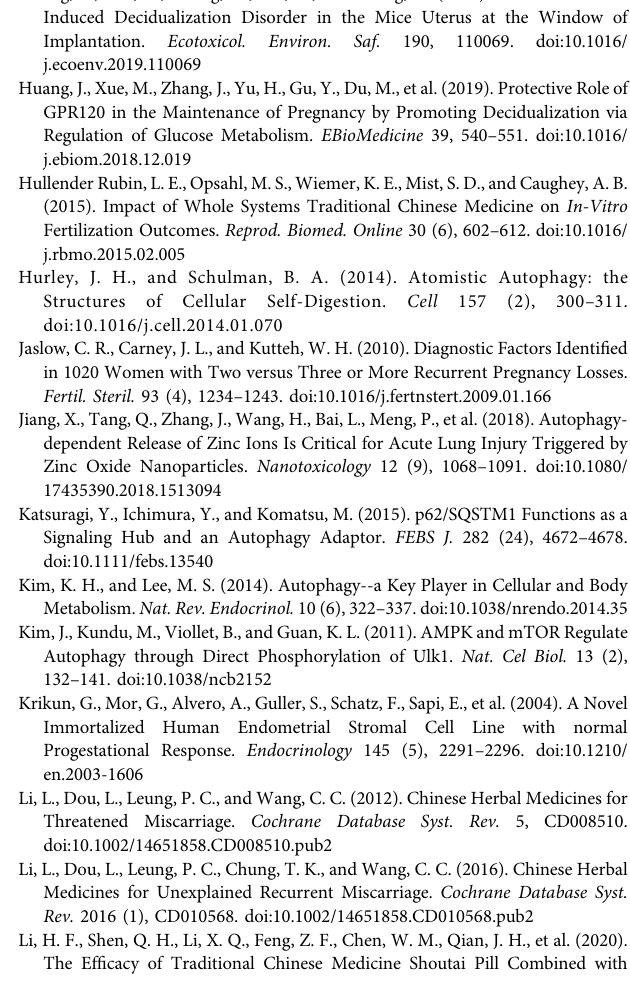
Supplementary Figure S1 | The information obtained by secondary mass spectrometry. Supplementary Figure S2 | CCK-8 assay was utilized to calculate the cell viability of each group. Supplementary Figure S3 | Selection of the AMPK siRNA with best knockdown ef fi cacy. * p < 0.05 vs. Scrambled siRNA group; ** p < 0.01 vs. Scrambled siRNA